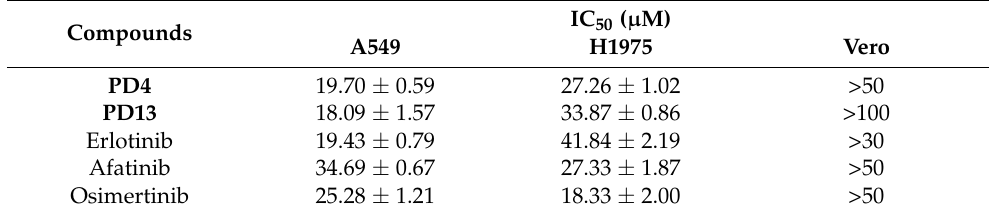
Table 3. In vitro anticancer activity of focused PD and drugs against NSCLC and normal cell